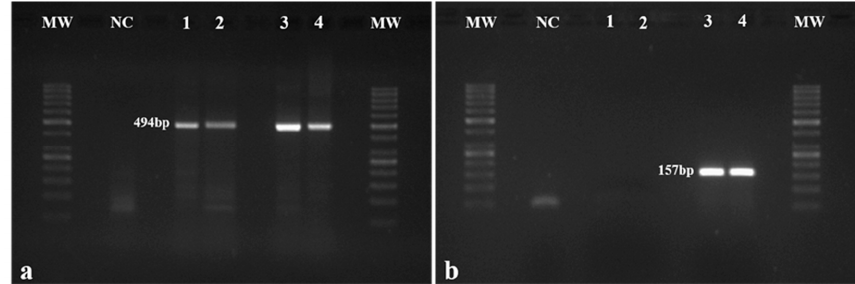
Figure 1. Mouse genotyping. ( a ) β -globin gene in mice was amplified by PCR and used as control. β -globin amplification (494 bp fragment) was observed in all mice; ( b ) The presence of the HPV16 early region was assessed by the amplification of the HPV16 E7 gene (157 bp fragment). As expected, amplification was not observed in wild-type mice (Groups 1 and 2 represented by Samples 1 and 2, respectively) but only in HPV + animals (Groups 3 and 4 represented by Samples 3 and 4, respectively). MW: molecular weight marker (GeneRuler 50 bp, Thermo Scientific, Waltham, MA, USA). NC: negative control.